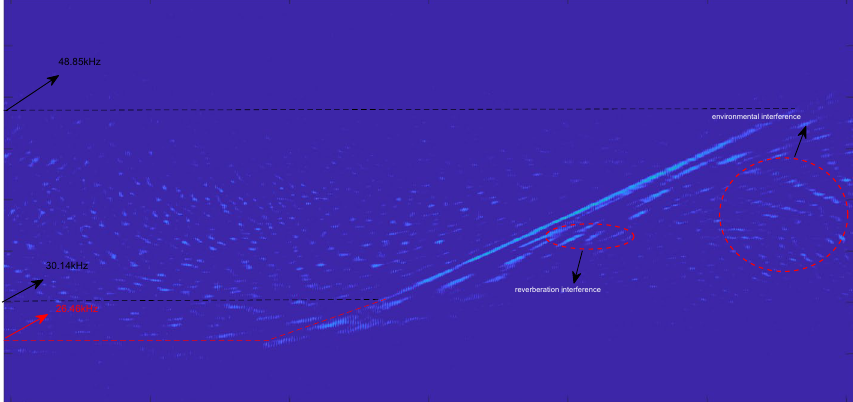
Fig. 11 Time–frequency distribution of observed reverberation signal with proposed